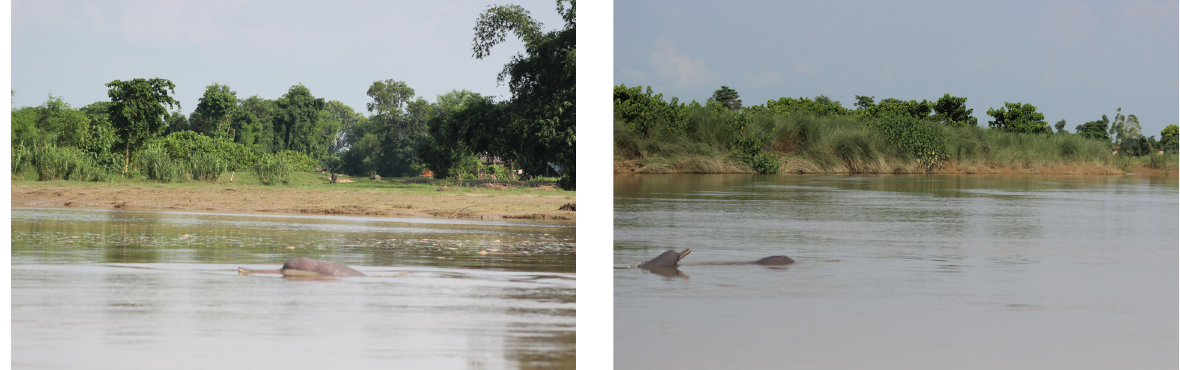
Table 1. Dolphin counts in different rivers of Nepal during July– August 2016. Name of the river Mohana and its 1 tributaries